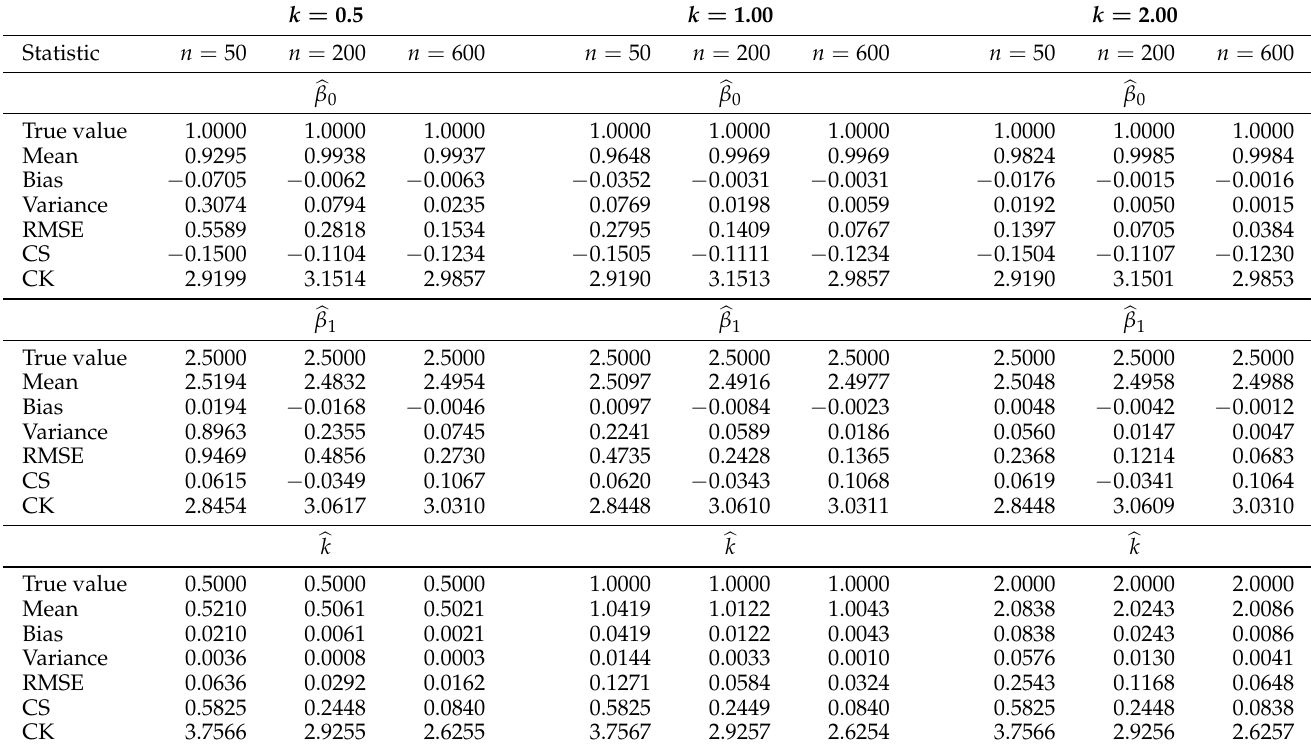
Table 7. Statistics from simulated Weibull regression data ( q = 0.90, β 0 = 1.00, β 1 = 2.50). k = 0.5